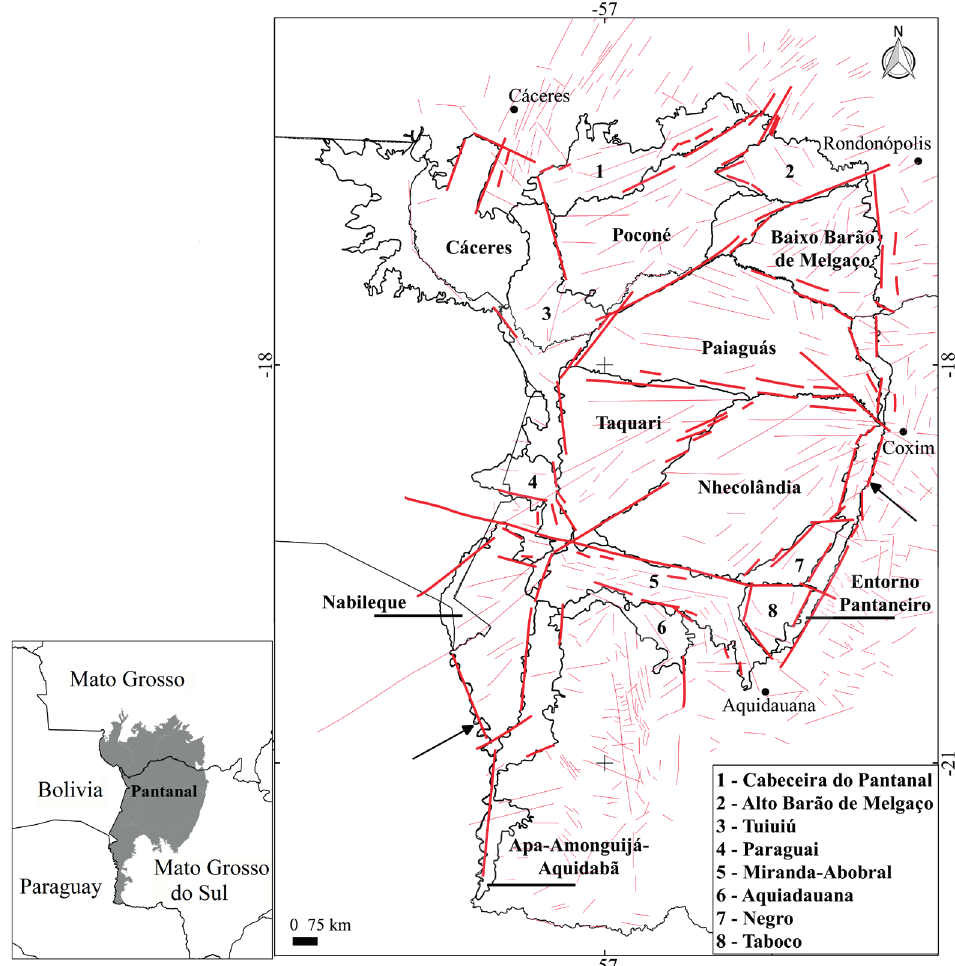
Figure 7 - Structural lineaments (in red) that coincide with the boundaries proposed by Mioto et al. (2012) (in black). the arrows indicate the external boundaries concordant with the structural lineaments, being the eastern boundary marked by the Maracajú System. the Paiaguás, taquari, Negro and Nhecolândia (which form the taquari river mega-fan) coincide entirely with the structures, as well as Pantanais do taboco, Baixo Barão de Melgaço and Entorno